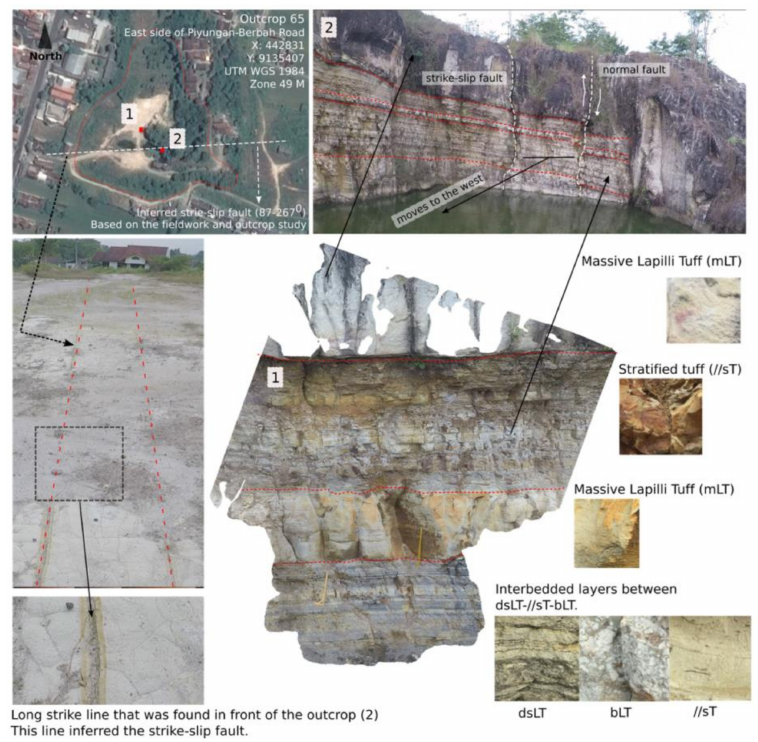
Figure 19. The fault evidence on the outcrop 65 segment 2 (picture no.